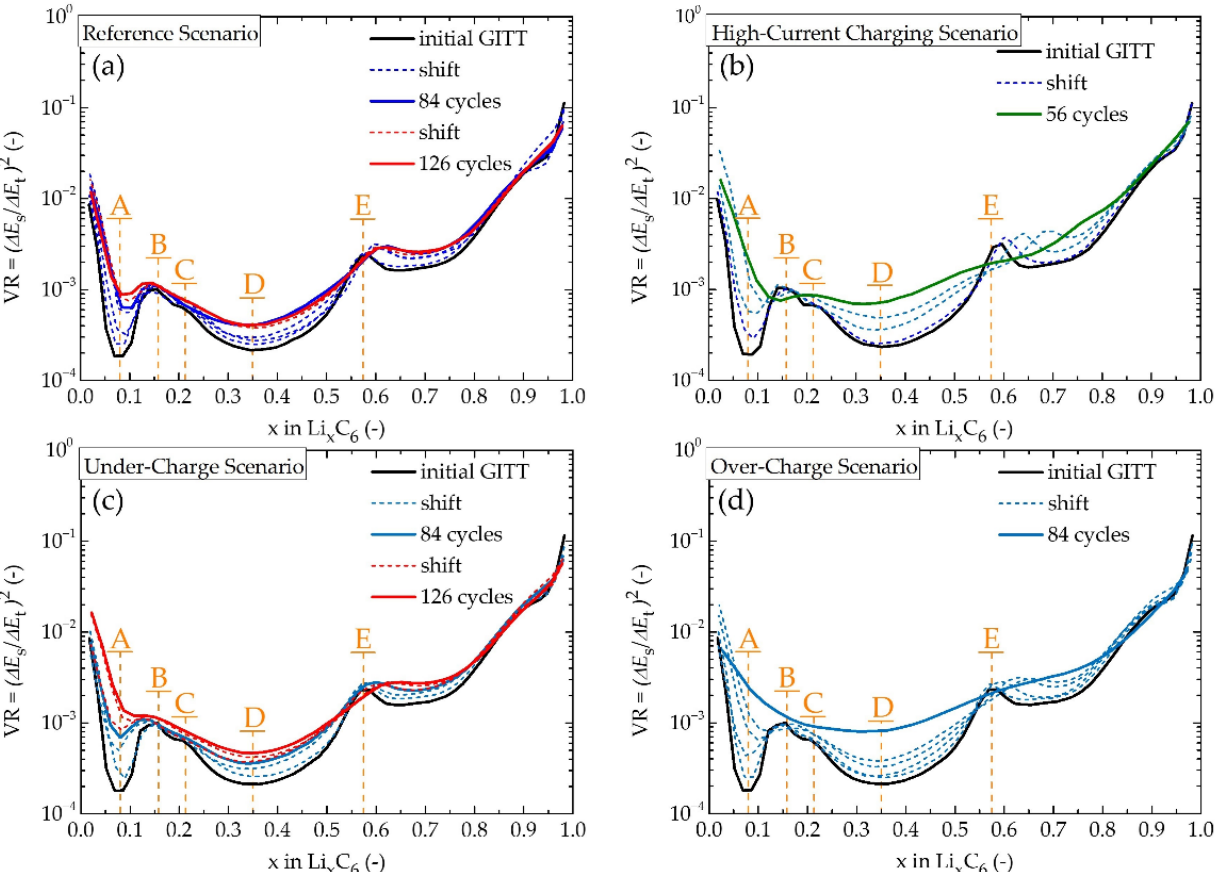
Figure 7. VR parameters as a function of x in Li x C 6 , where ( a ) refers to Reference Scenario , ( b ) High- Current Charging Scenario , ( c ) Under-Charge Scenario , and ( d ) Over-Charge Scenario .